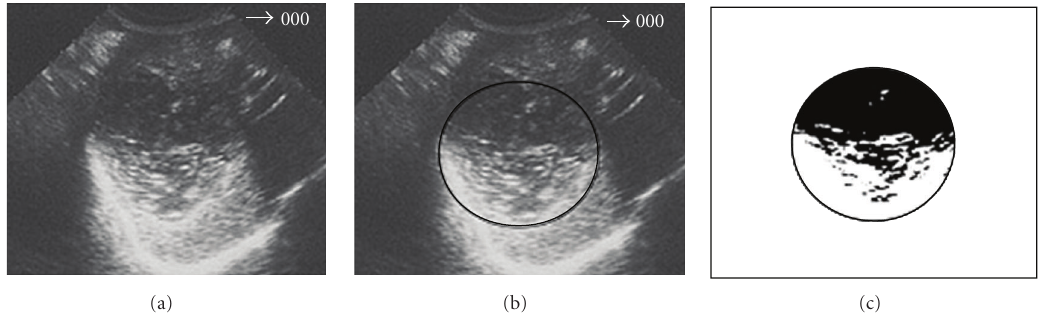
Figure 7: Hydatid cyst of the liver after treatment: 55% content solidification.